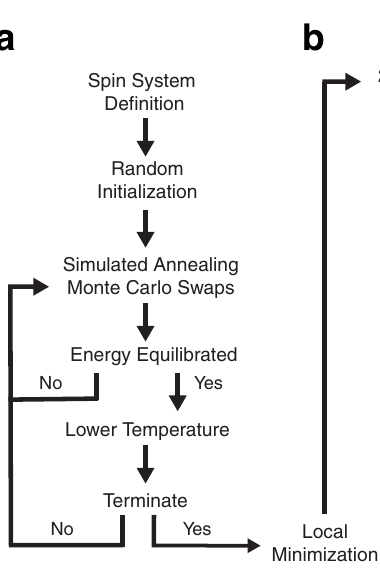
Fig. 1 | Outline of the BARASA triple resonance assignment algorithm. a The search engine rests on a Bayesian-based simulated annealing protocol that uses a speci fi c-heat mechanism to guide cooling. Crosspeaks lists drawn from triple resonance spectra are assembled into putative spin systems, which are then ran- domlyassignedtopositionswithintheprimarysequenceoftheprotein.Sequential adjacency in the primary sequence is provided by apparent connectivities derived from triple resonance NMR spectra. Predicted chemical shifts, based on a high- resolution structural model or gleaned from empirical amino acid-speci fi c dis- tributions, are incorporated into the system energy using Bayesian statistics. Throughout annealing, crosspeaks may move among spin systems with over- lapping resonances, changing the energies of the affected spin systems. Annealing